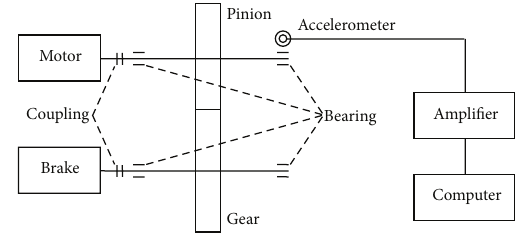
Figure 2: Gearbox experimental setup.